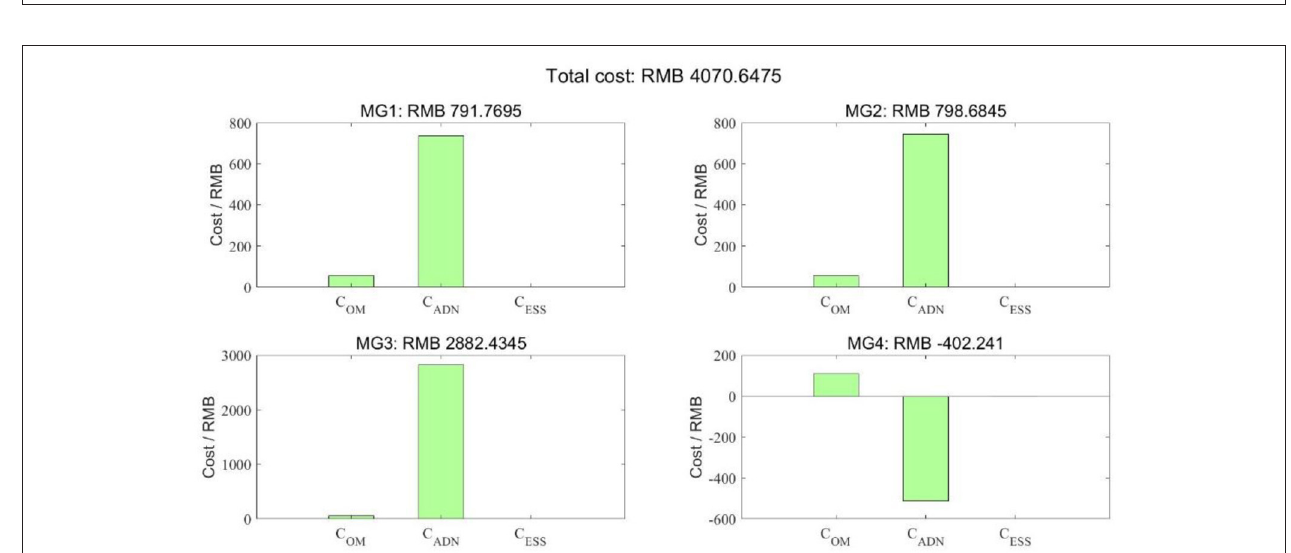
FIGURE 6 | The energy bills of each microgrid within the cluster in scenario 2.